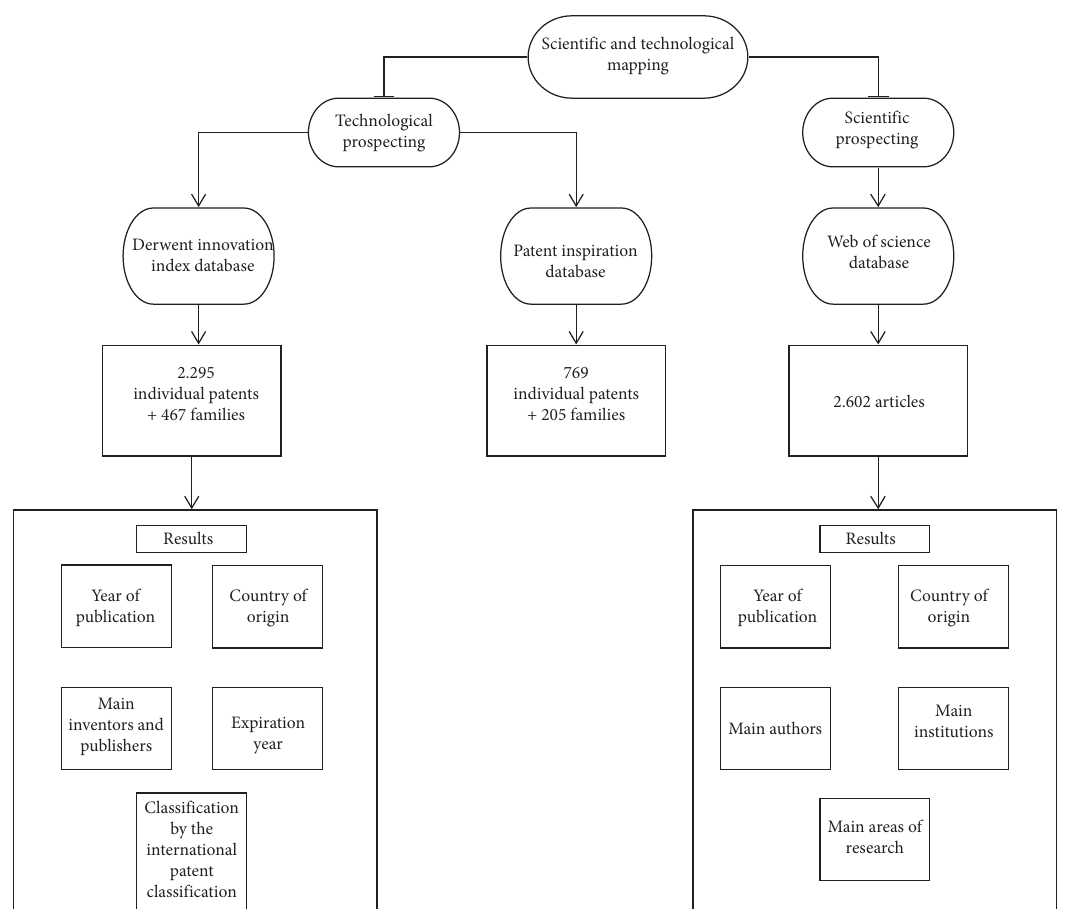
Figure 1: Flowchart of the methodology performed in this